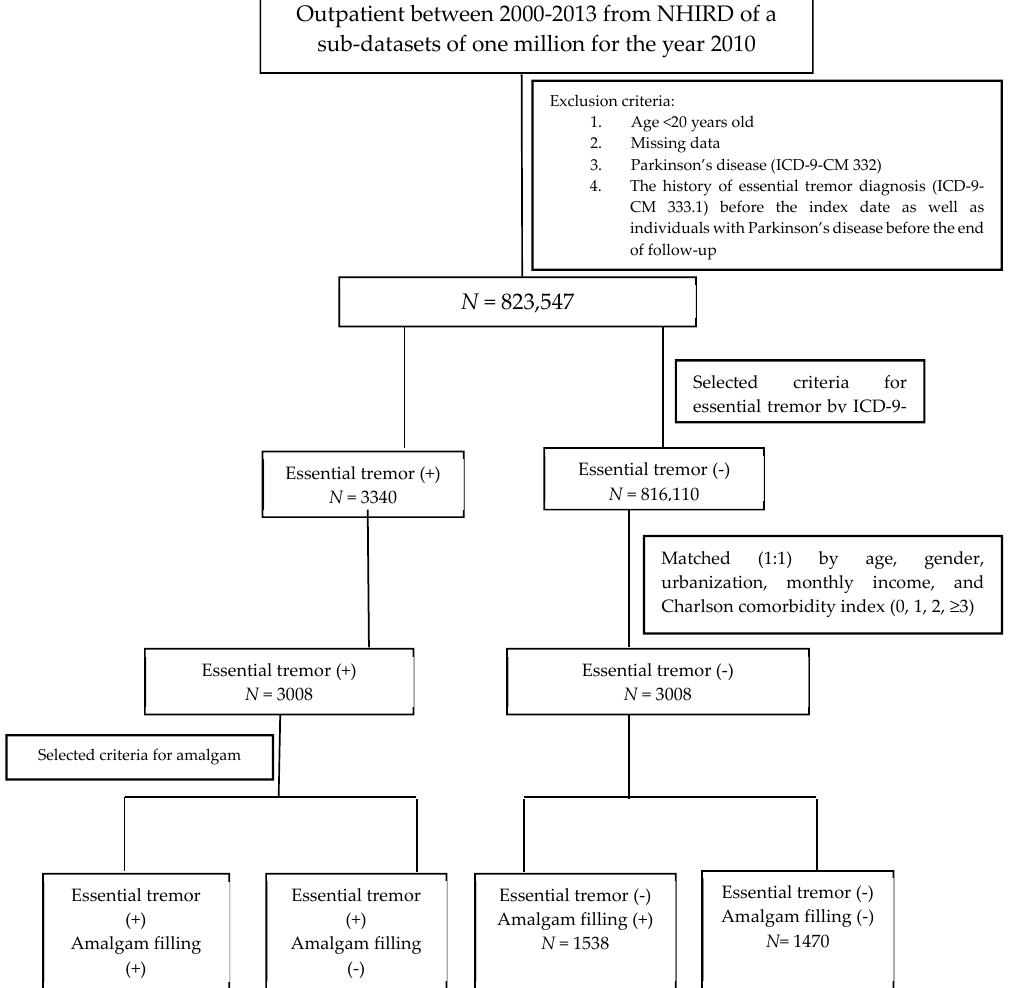
Figure 1. The flowchart of the study.